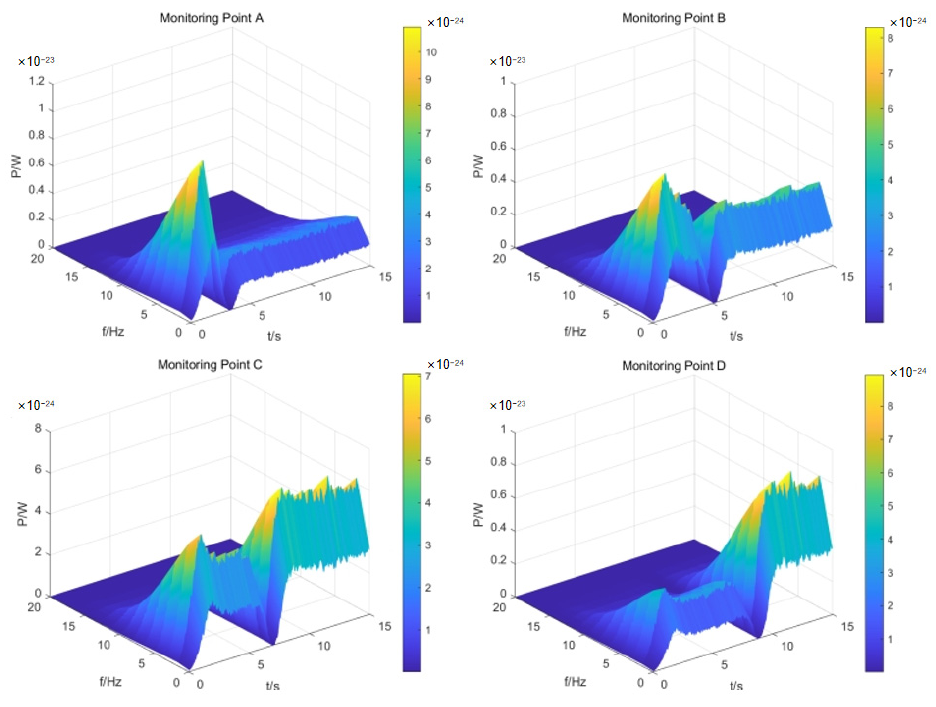
Figure 9. The time-frequency domain diagram of the magnetic field at the monitoring point when the submarine moves at a speed of 2 m/s.